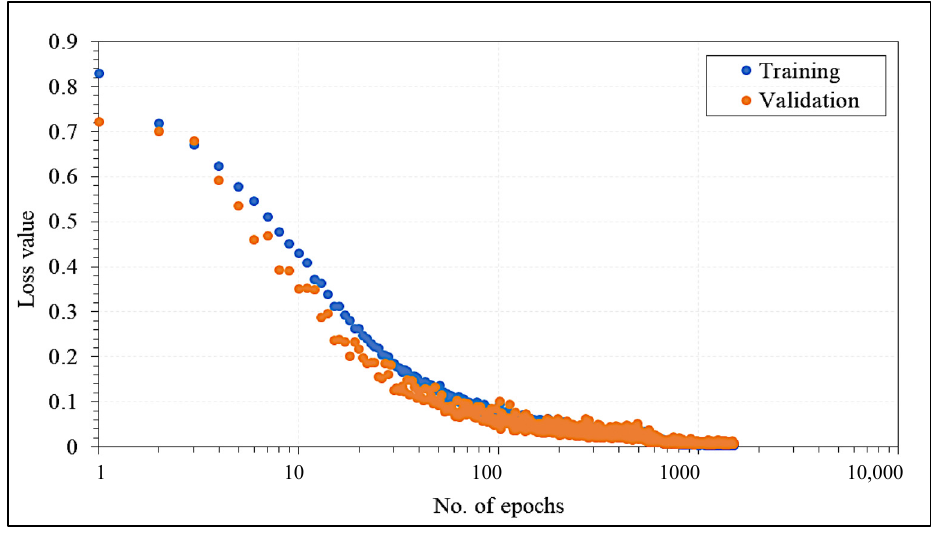
Figure 13. Model convergence. Table 4. Model performance